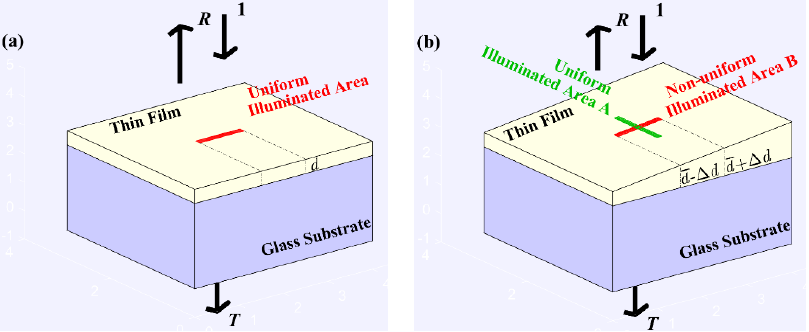
Figure 1. Geometry of ( a ) a uniform, and ( b ) a non-uniform weakly-absorbing thin film, onto a thick transparent glass substrate.